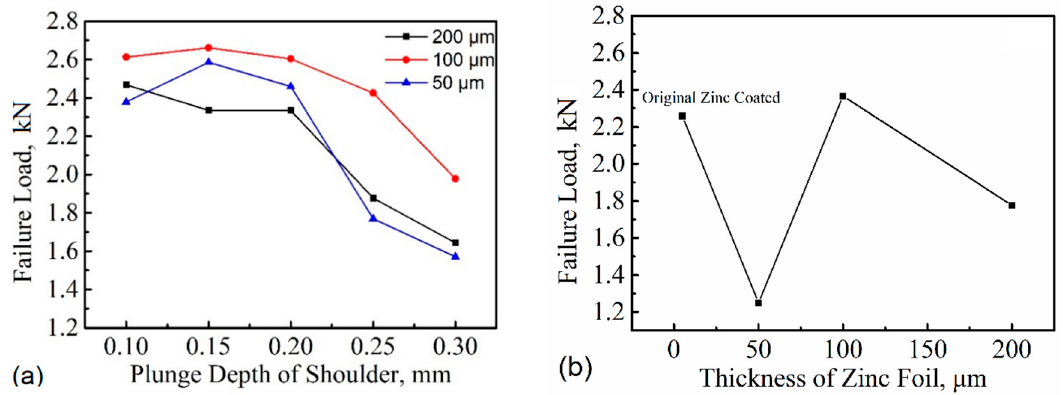
Figure 4. ( a ) The change of tensile load with the plunge depth of the shoulder and ( b ) maximum tensile load varies with zinc foil thickness.